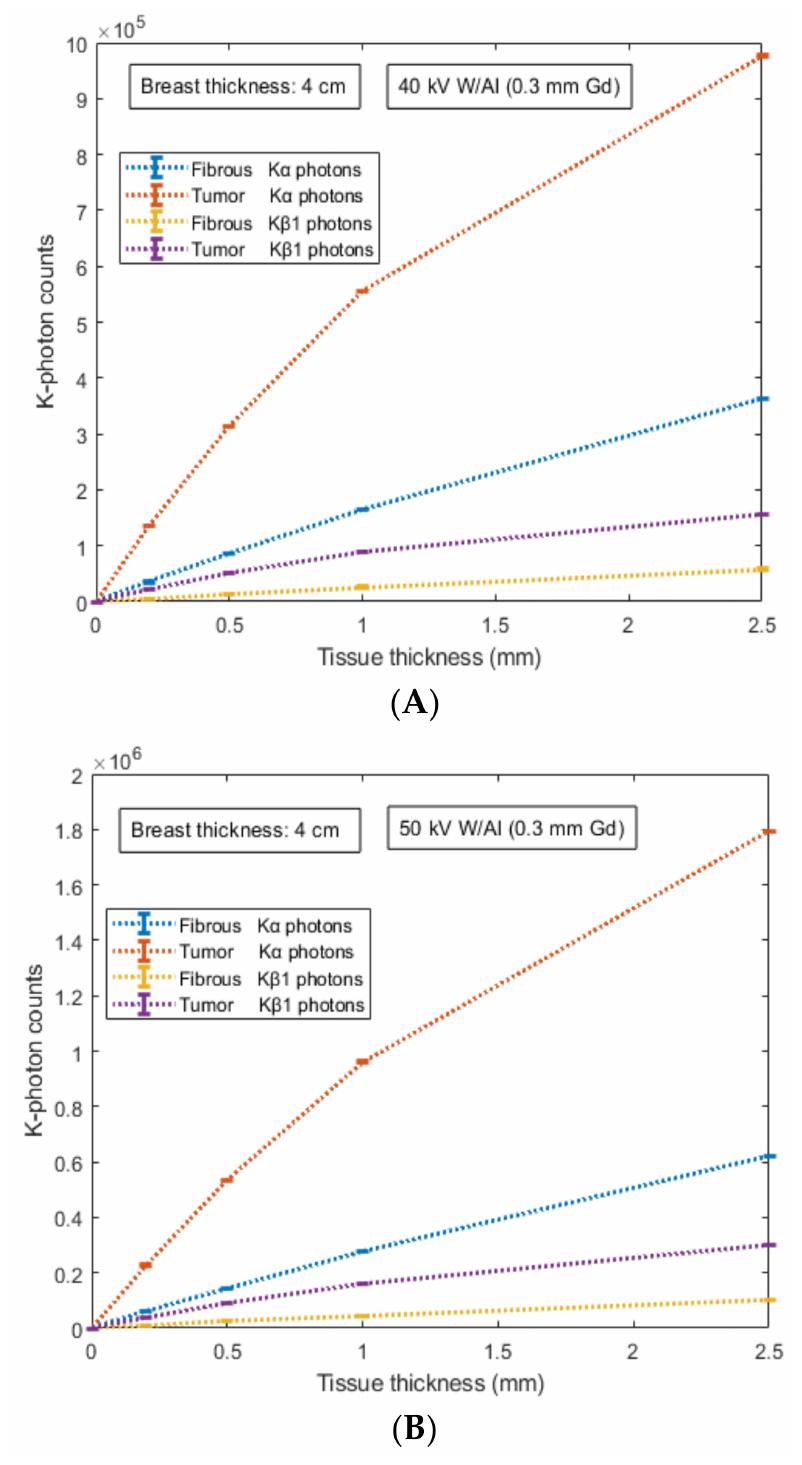
Figure 5. Figure shows the number of K -X-rays ( K α and K β 1 ) counted by the 700 µ m converter layer of the Si detector. Results are provided for: (a) two X-ray spectra: ( A ) 40 kV- W/Al (1.6 mm) and ( B ) 50 kV- W/Al (1.6 mm) with additional filtration 0.3 mm Gd; (b) two types of internal tissue (fibrous and tumor) with thicknesses ranging from 0.2 mm up to 2.5 mm; and (c) external fat tissue of 4 cm thickness. Numerical values are expressed by the mean value and their corresponding standard